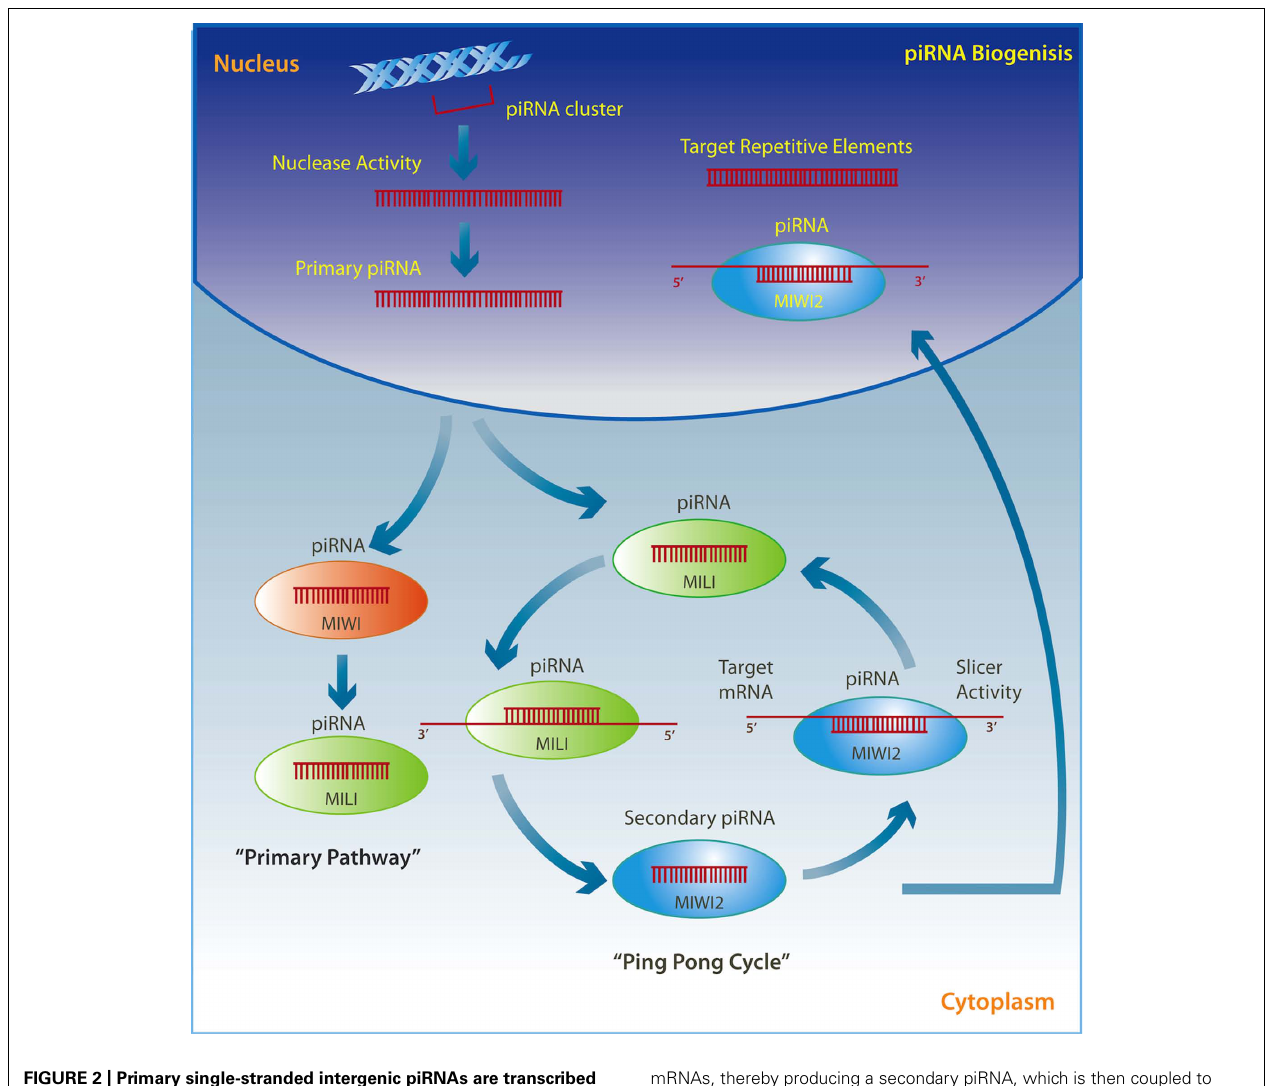
mRNAs, thereby producing a secondary piRNA, which is then coupled to MIWI2. MIWI2 piRNA can return to the nucleus where it targets repetitive elements, or remains within the cytoplasm where it exerts endonuclease activity on the opposite strand to reproduce a new pre-piRNA that interacts with MILI in a self-amplification